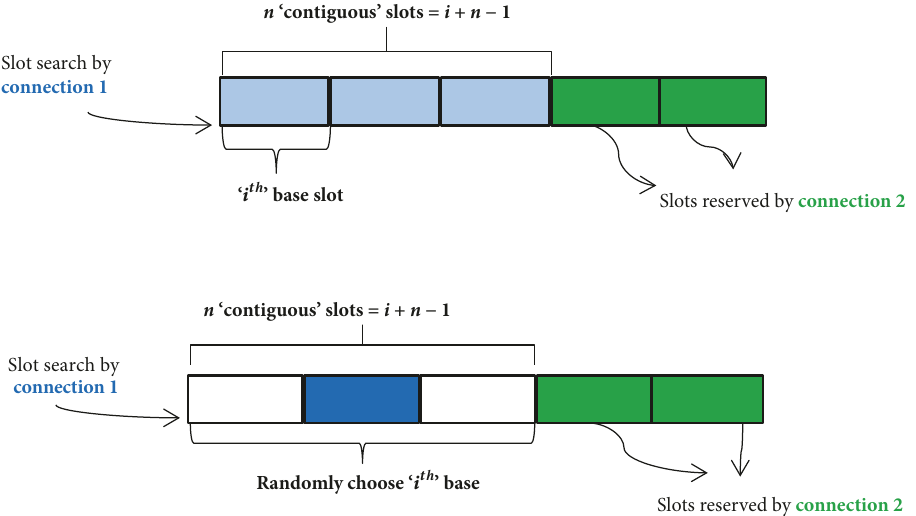
Figure 6: (a) First Fit Policy (FF): select the first free slot as the base slot; (b) random Fit (RF): identify slots of “m” range and select a base slot randomly.